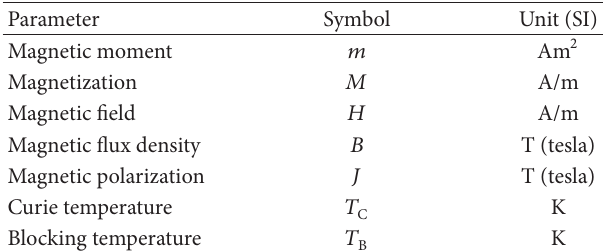
Table 1: The list of some critical magnetic parameters with their units in SI